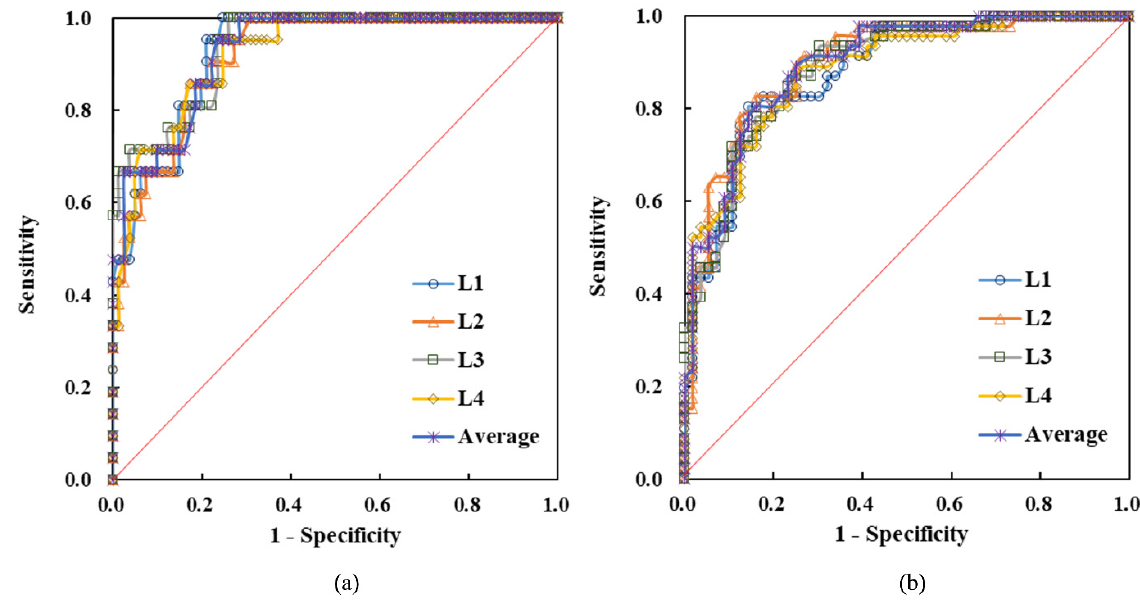
Figure 9. ROC analysis to estimate the diagnostic ability of vBMD in predicting ( a ) osteoporosis and ( b ) osteopenia. The average AUC for diagnosing osteoporosis and osteopenia is 0.930 and 0.897, showing considerably good results. Table 2. Threshold, sensitivity, and specificity values in the diagnosis of osteoporosis and osteopenia obtained using ROC analysis with vBMD.